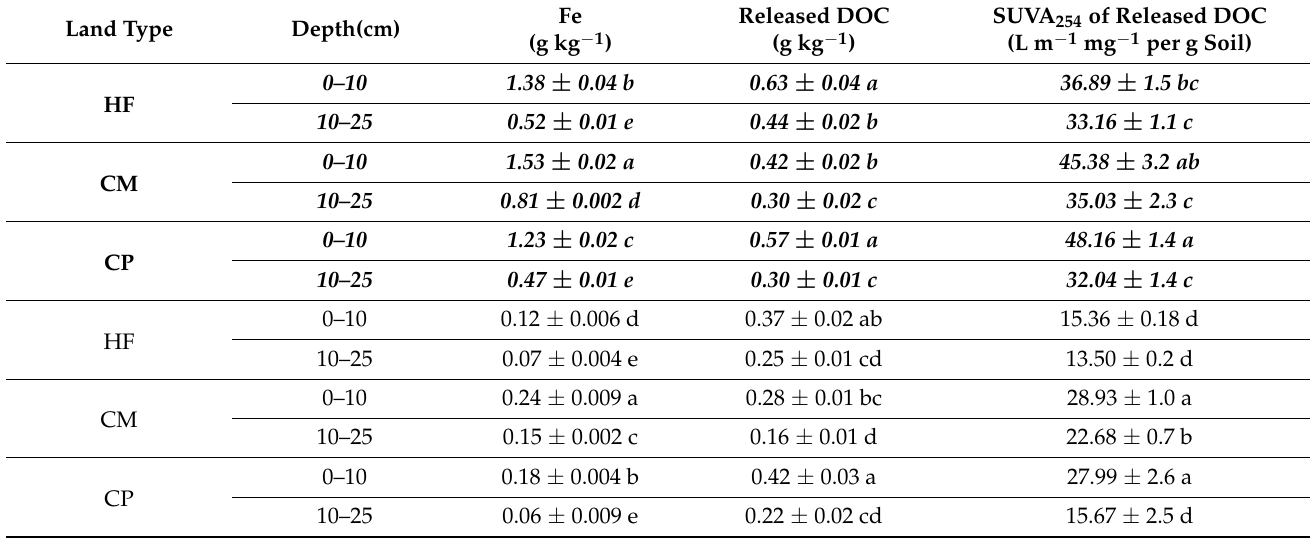
Table 2. Amount of released Fe, DOC (dissolved organic carbon), and SUVA 254 (absorbance of DOC at 254 nm) of DOC released from soils after 0.5 N HCl at 0–10 cm and 10–25 cm, 0.25 N HCl and 0.25 N NH 2 OH · HCl extraction ( bold and italicized ) at 0–10 cm and 10–25 cm in hardwood forest (HF), cropland with manure (CM) and continuous pasture